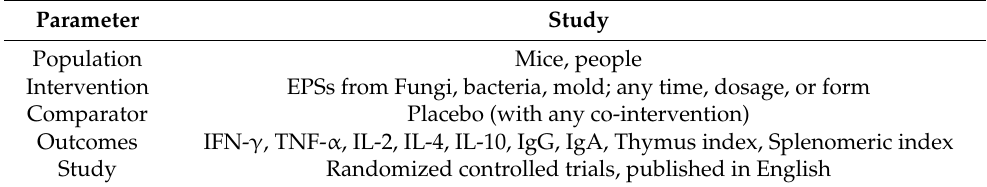
Table 1. PICOS criteria for inclusion of